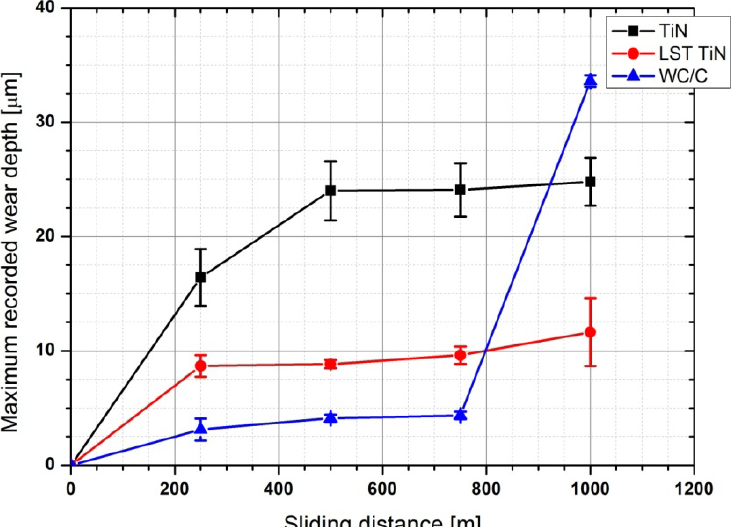
Figure 10. Maximum depth recorded within the wear track versus sliding